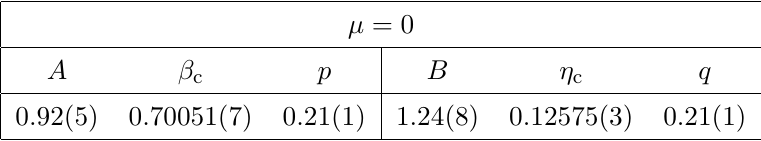
Table 2 . Fit results for ∆ h L i at µ = 0 in the (2+1) d